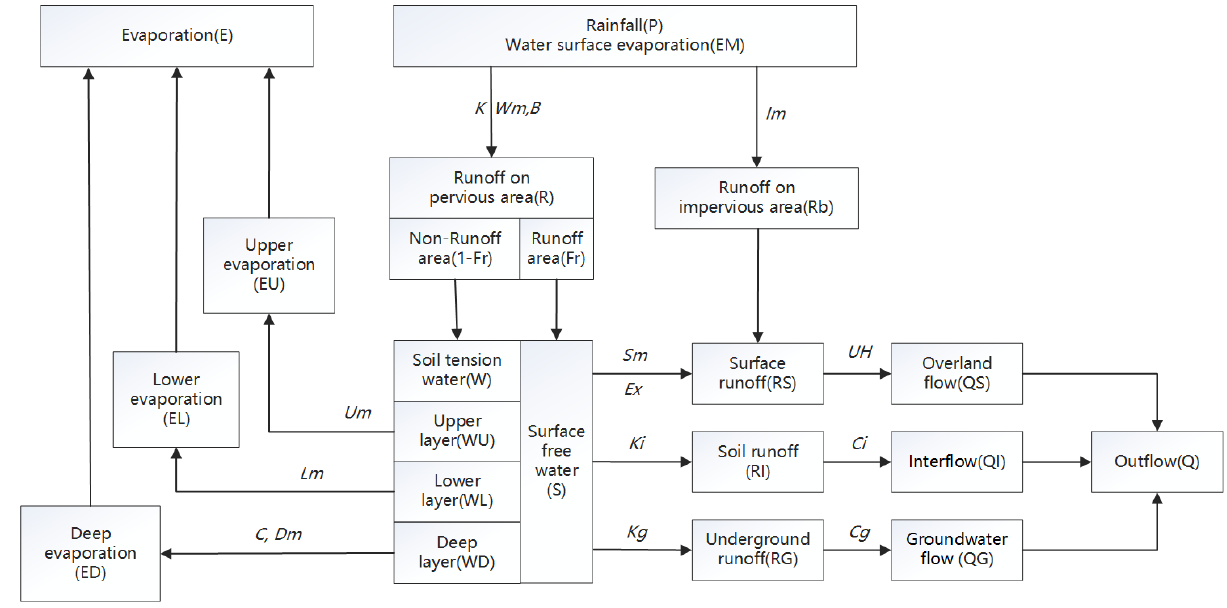
Figure 2. Computation flow of the Xinanjiang model. Table 2. Physical meanings and units of model parameters.